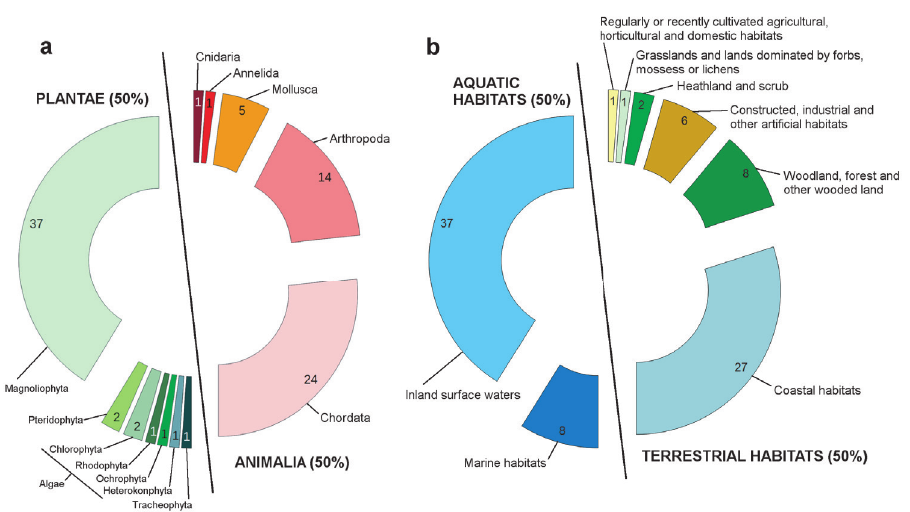
Figure 1. a Taxonomic groups represented in 90 action plans evaluated in this study. The taxonomic classification is based on BOLD (Barcode of Life Data system), a cloud-based data storage and analysis platform developed at the Centre for Biodiversity Genomics in Canada (http://www.boldsystems.org) b major habitat types represented in these action plans, following the EUNIS classification. Numbers inside the pie chart indicate the number of actions for